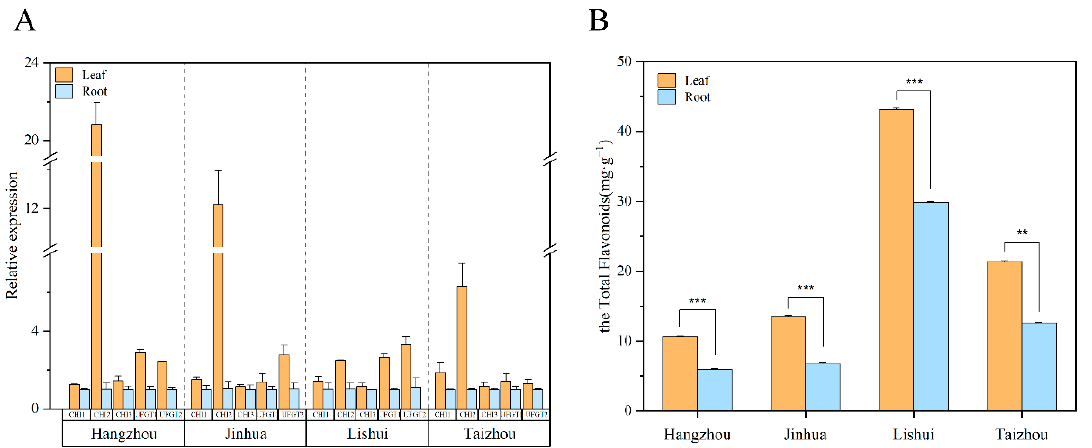
Figure 9. Expressions of flavonoid synthesis key genes and total flavonoid content of Zhejiang T. hemsleyanum from different locations. ( A ) Expression of flavonoid synthesis key genes of Zhejiang T. hemsleyanum from different locations (CHI 1, CL6715.Contig1_All; CHI 2, Unigene19431_All; CHI 3, CL921.Contig4_All; UFGT 1, CL11556.Contig3_All; UFGT 2, CL11775.Contig1_All.). ( B ) The concentration of total flavonoids of Zhejiang T. hemsleyanum from different locations (different symbols mean a significant difference, ** represents p ≤ 0.01, *** represents p ≤ 0.001).